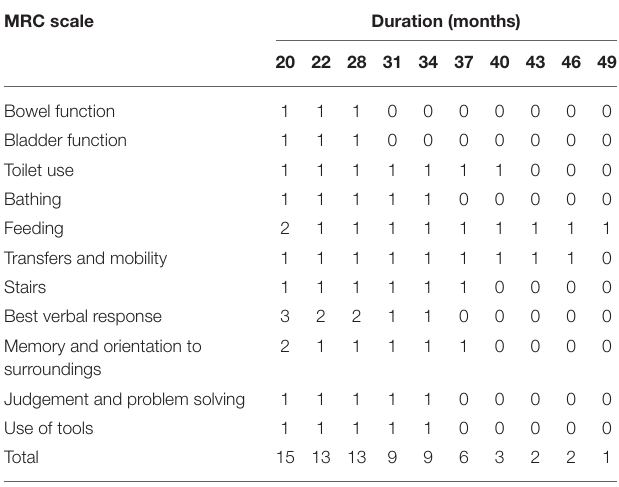
TABLE 1 | The MRC Scale of the